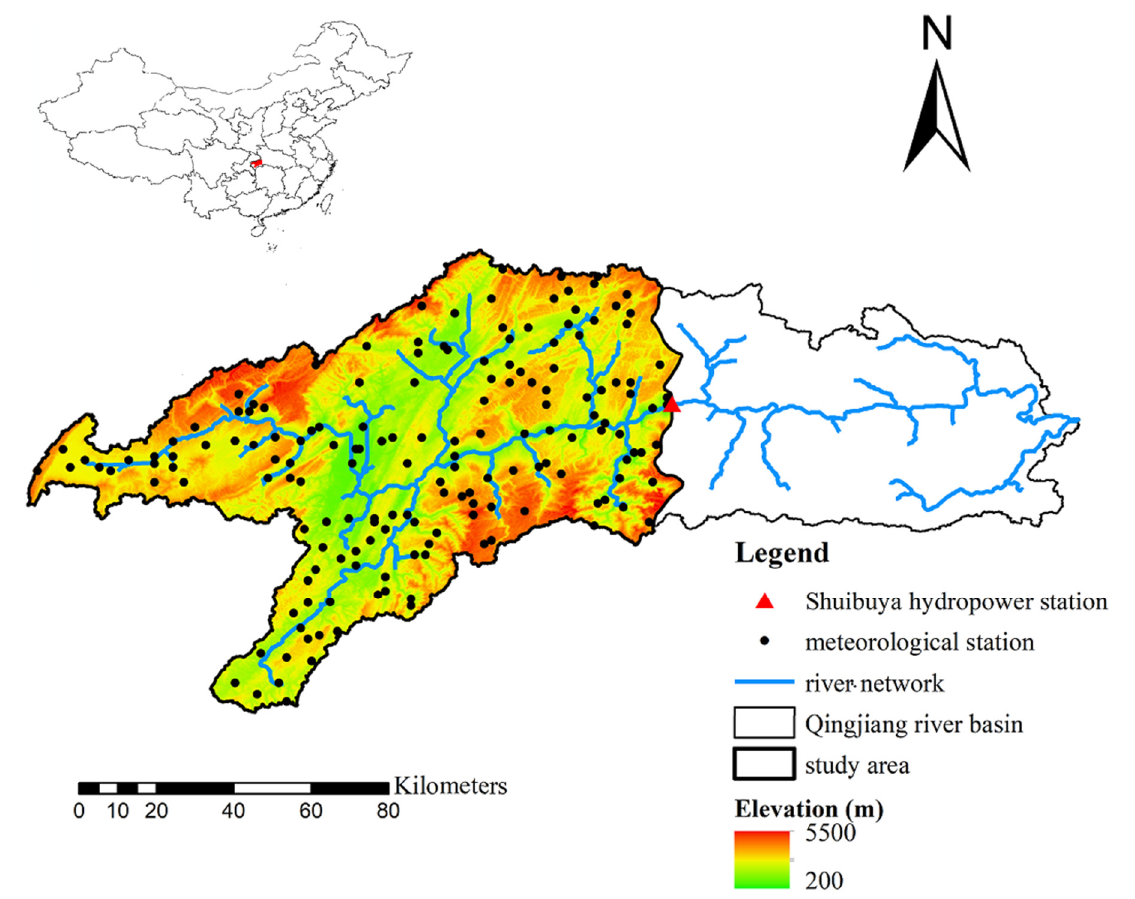
Figure 1. The study area.